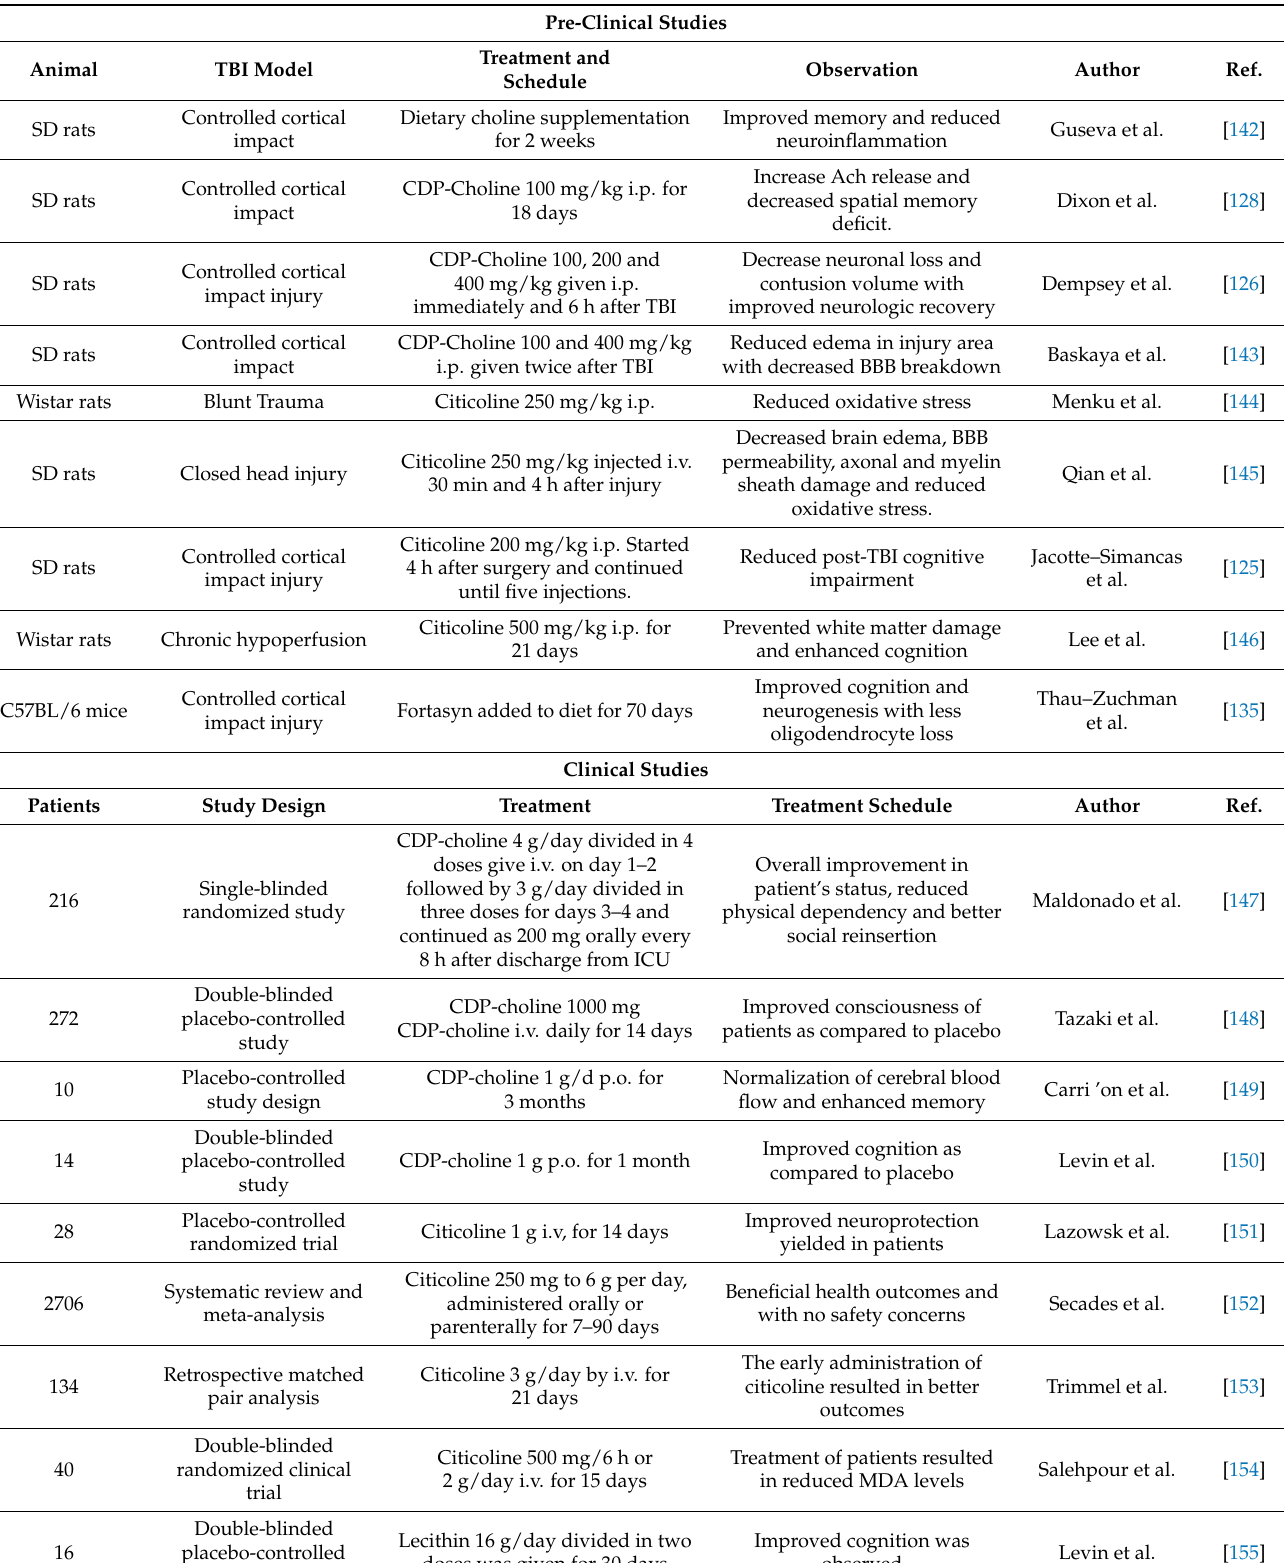
Table 4. Preclinical and clinical studies reporting the improvement of brain function through providing the choline-targeted post-TBI